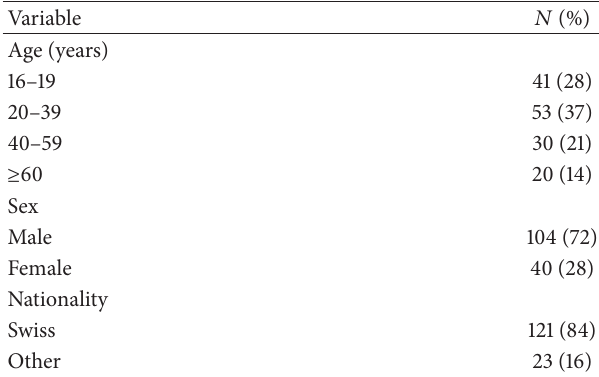
Table 2: Demographic details ( 𝑁 = 144